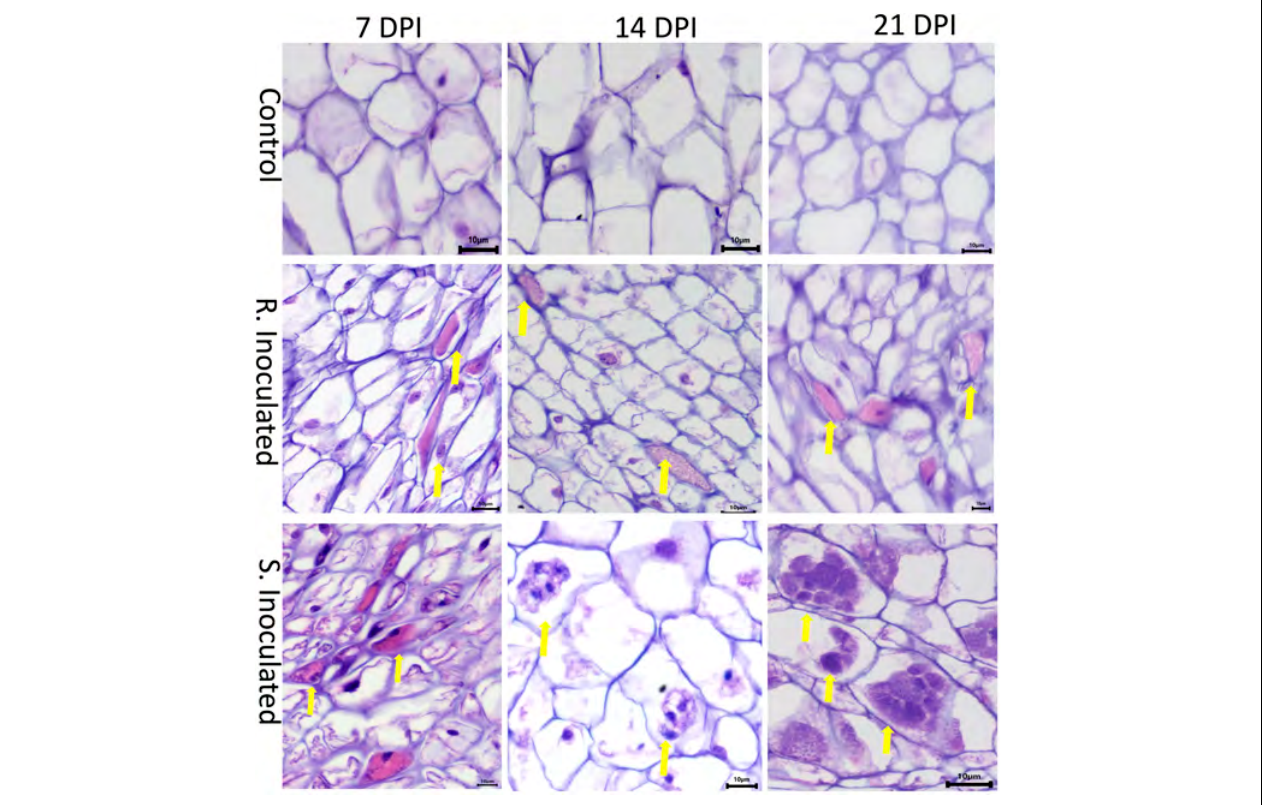
FIGURE 2 | Histology images of root cross sections after P. brassicae infection at 7-, 14-, and 21-days post inoculation (DPI). Root tissues were stained with eosin and hematoxylin. Each column indicates DPI of the pathogen and the rows show the control and inoculated genotypes [clubroot- susceptible (CS) and resistant (CR) lines]. At 7 DPI, infected cells showed primary plasmodia with dark purple mass within cells indicated by the solid yellow arrow. At 14 DPI, CS inoculated line showed the presence of secondary plasmodia; however, the pathogen development on the CR inoculated line was not progressed to secondary plasmodia phase. At 21 DPI, pathogen clearly progressed to secondary plasmodia phase, maturing into developing resting spores in the CS line. However, the infection development was not progressed further at the same time point on the CR